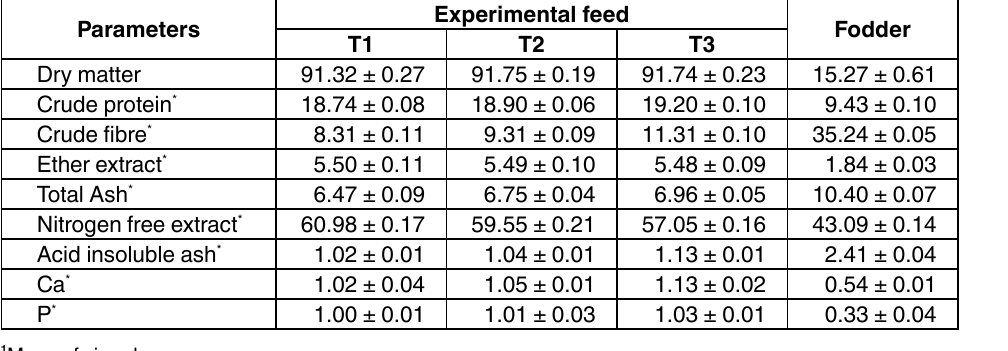
table 3. Chemical composition of feed and fodder¹,